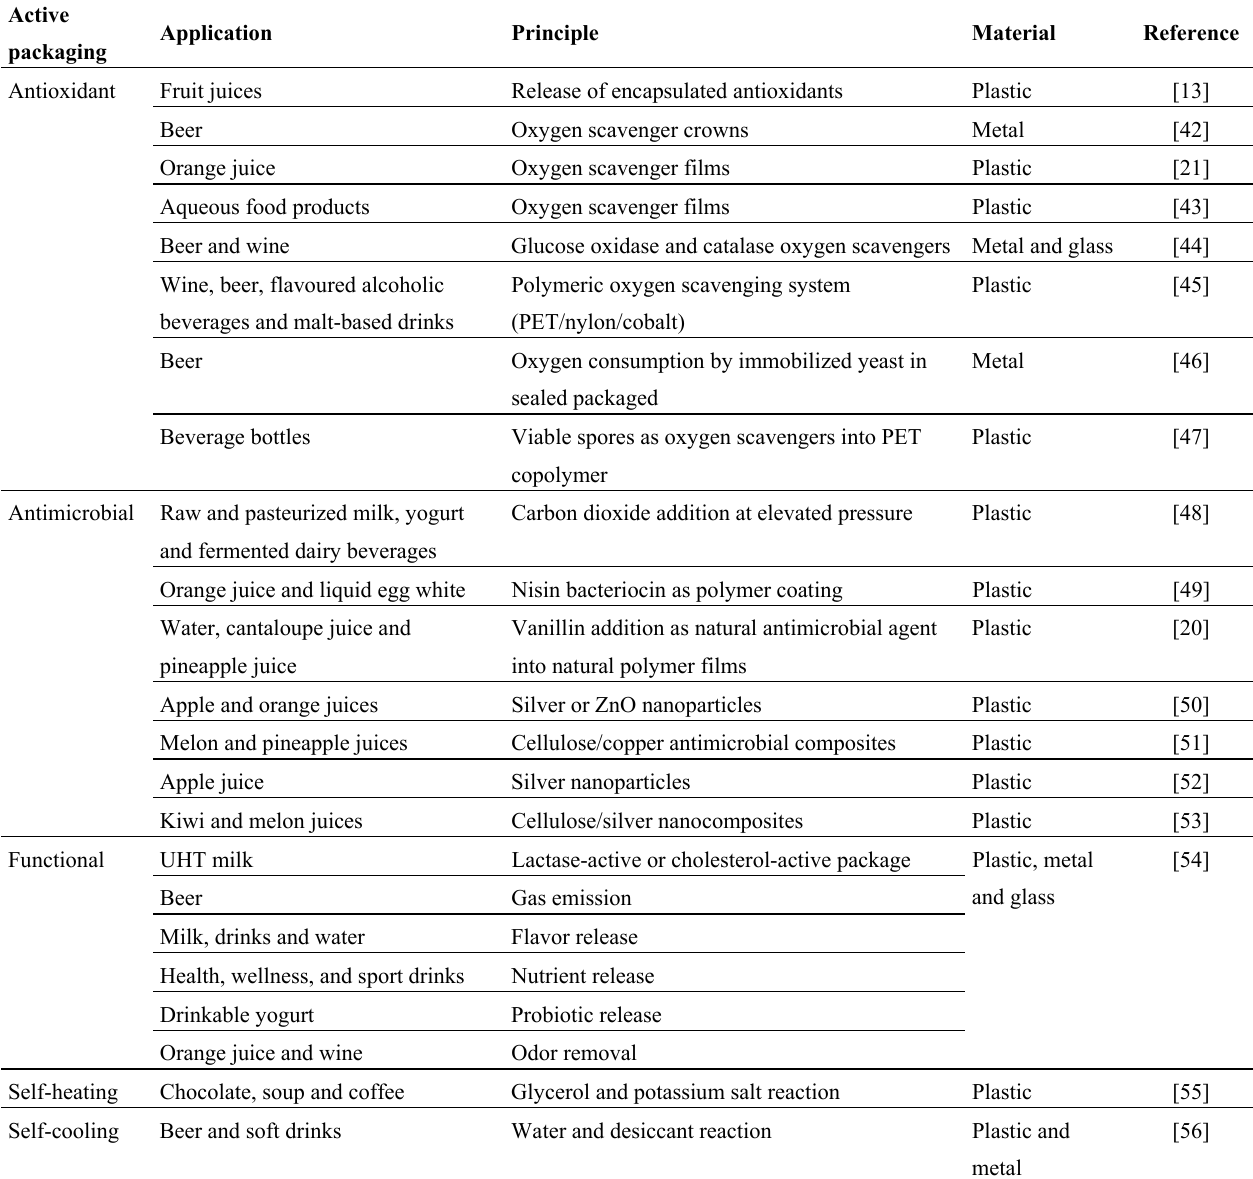
Table 2. Recent trends in active beverage